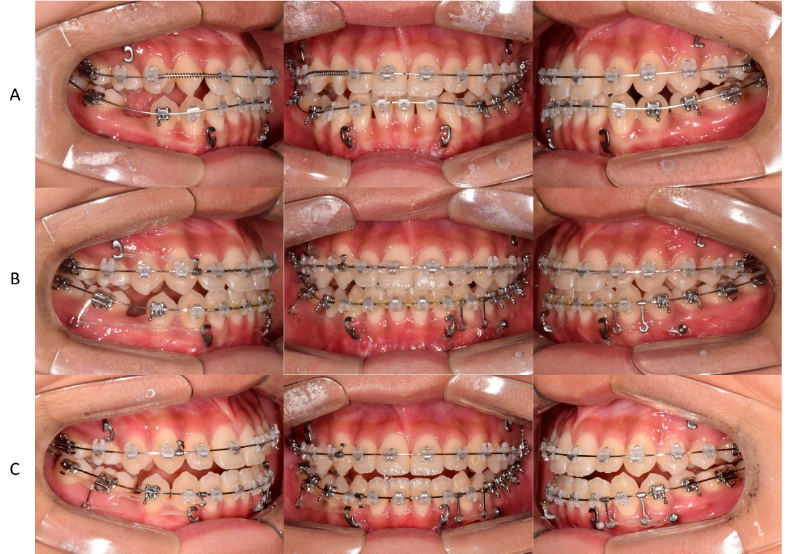
Figure 5. Nonsurgical orthodontic treatment process using a fixed appliance. ( A ) space regaining for maxillary right lateral incisor arrangement after bonding the fixed appliance. ( B ) Closing the mandibular extraction space using the miniplate anchorage, moving the maxillary midline to the right, and moving the mandibular midline to the left. ( C ) The mandibular extraction space was closed.